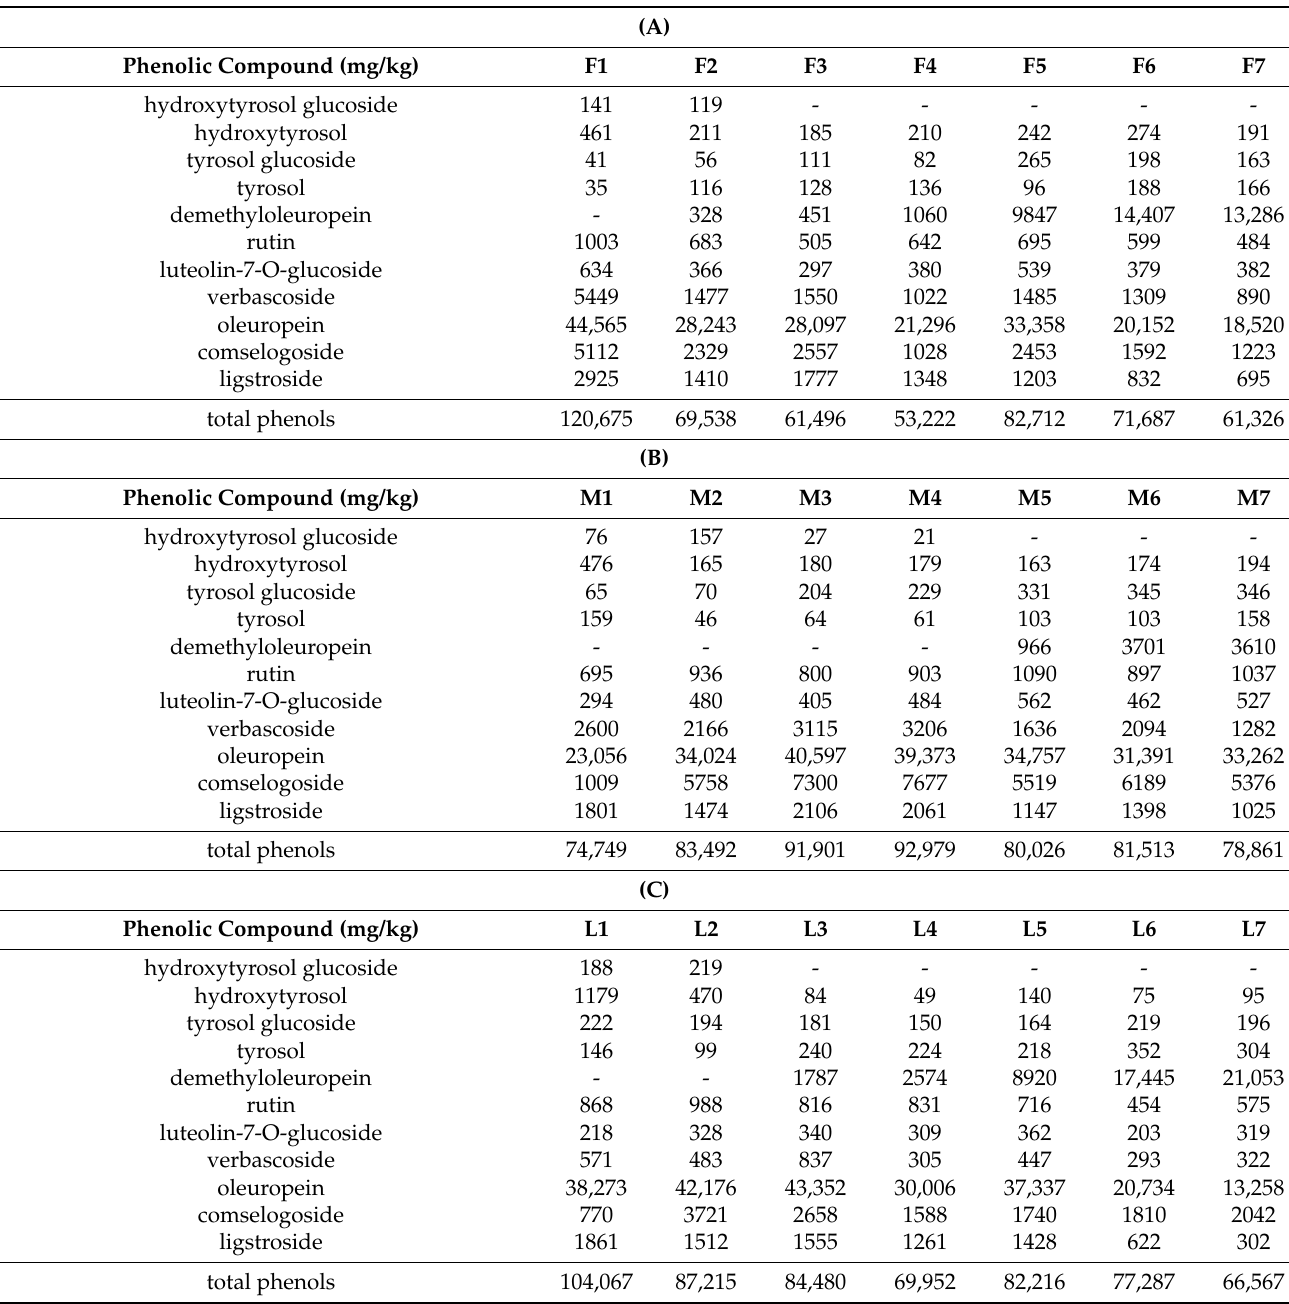
Table 3. Evolution of the content of phenolic compounds in the pulp of whole lyophilized olive fruits of (A) Frantoio cultivar, (B) Moraiolo cultivar, (C) Leccino cultivar. Results are expressed in mg/kg of whole dried olives. The RSD was <5% (values determined as a mean of five replicates of a mixture of different